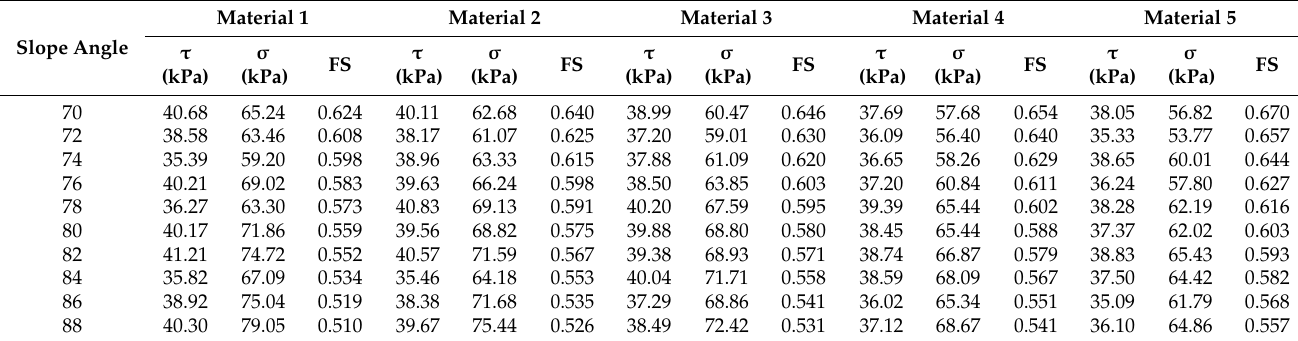
Table 2. τ and σ in the case of a saturated seismic analysis—Materials 1 to 5.